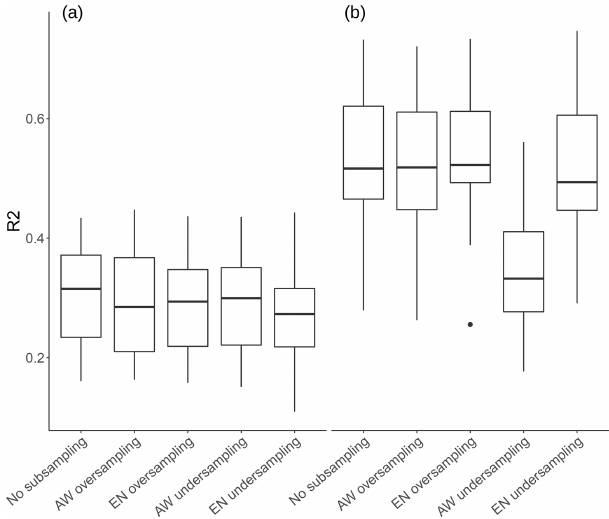
Figure 7. Landscape cluster-specific model performance of the silt model at 10cm depth with panel (a) showing the R 2 of the sam- ples from the lowlands cluster and panel (b) the samples from the mountainous